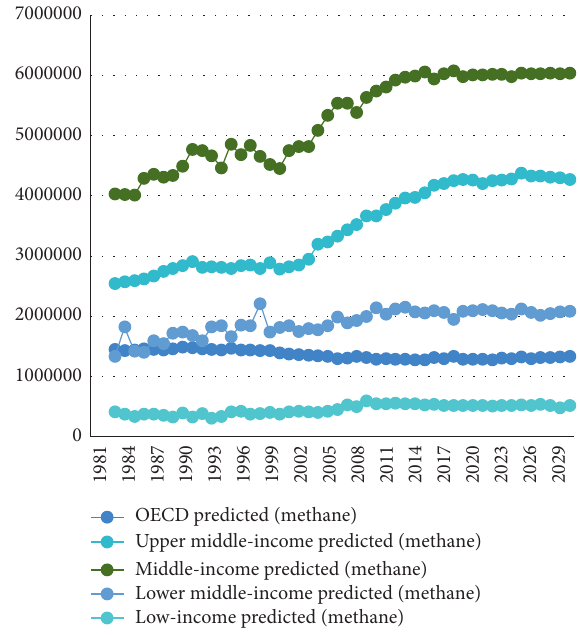
Figure 4: Forecasted methane emission by the ANN method. Source: sketched by the authors.